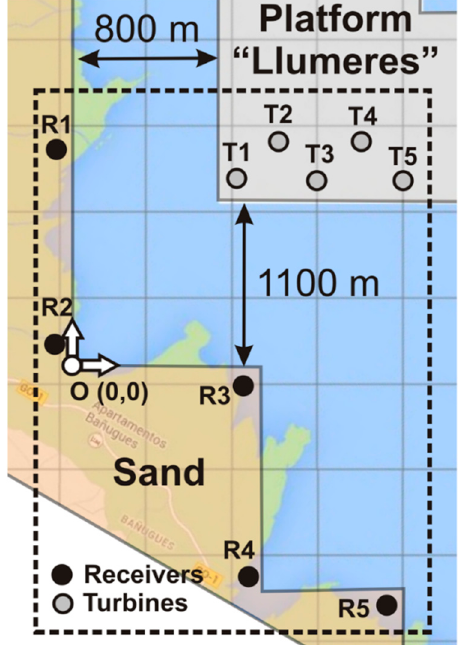
Figure 5. Sources and receivers’ positions for the Llumeres location.